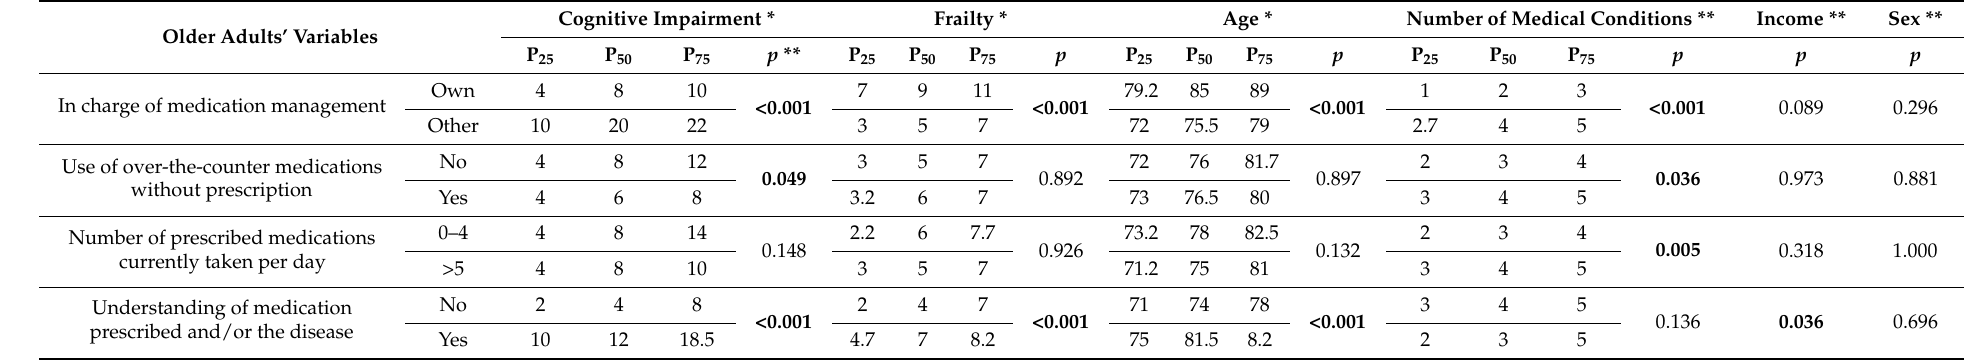
Table 3. Associations between medication management patterns and sociodemographic and clinical characteristics of the studied home-dwelling older adults ( n =